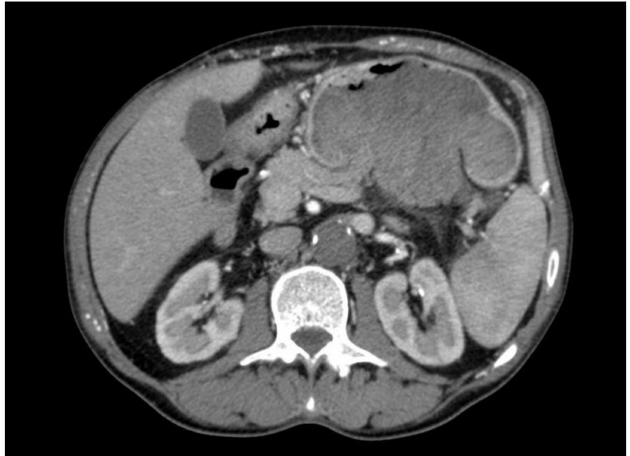
Figure 1. Mixed density solid gastric mass, hyperdense in the arterial phase (possible previous bleeding), occupying the entire lumen of the stomach.